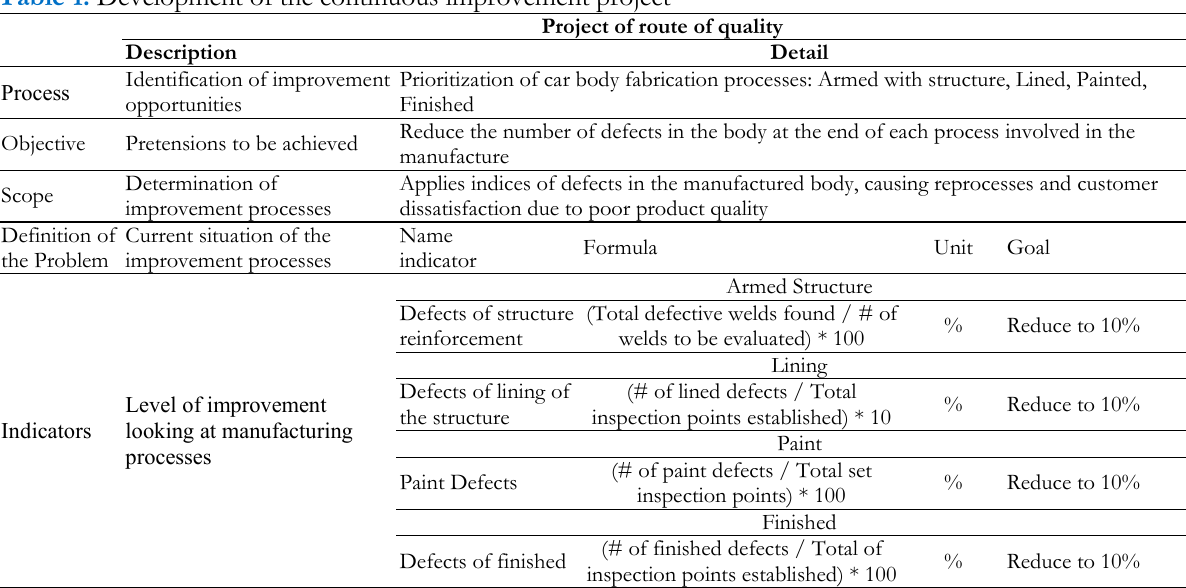
Table 1. Development of the continuous improvement